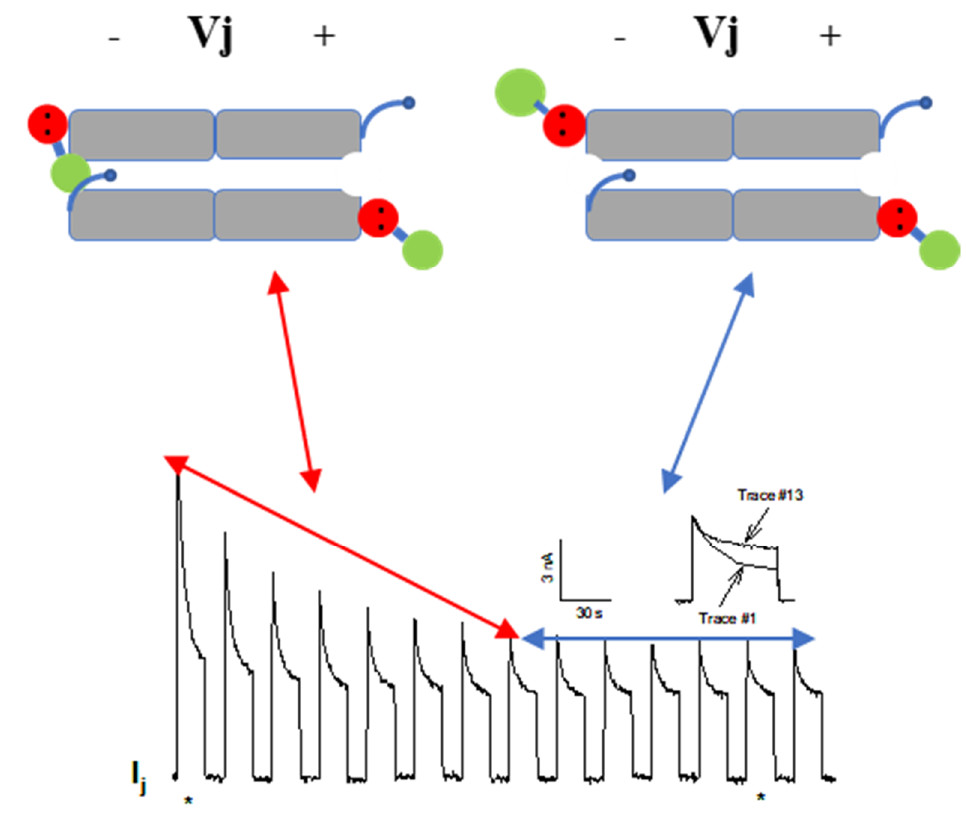
Figure 11. Gj slowly decays in oocytes expressing Cx32 subjected to long −100 mV Vj pulses. Note the progressive drop in Ij-Peak and, to a lesser extent, Ij-Steady-State. Gj peak drops exponentially by 50–60%, eventually reaching steady state. The large drop in Ij during the first 8 pulses is likely to result from the closure of both chemical/slow gate and fast Vj gate (double-headed red arrow). The Ij behavior of the following 6 Vj pulses is likely to reflect the closure of only the fast Vj gate of the remaining open channels (double-headed blue arrow). The CaM molecules are labelled in red and green colors to identify C-lobe and N-lobe, respectively. The inset shows a comparison of the time course of I j seen in traces #1 and #13 (the asterisks below the main tracing indicate their location). Adapted from ref. [124].